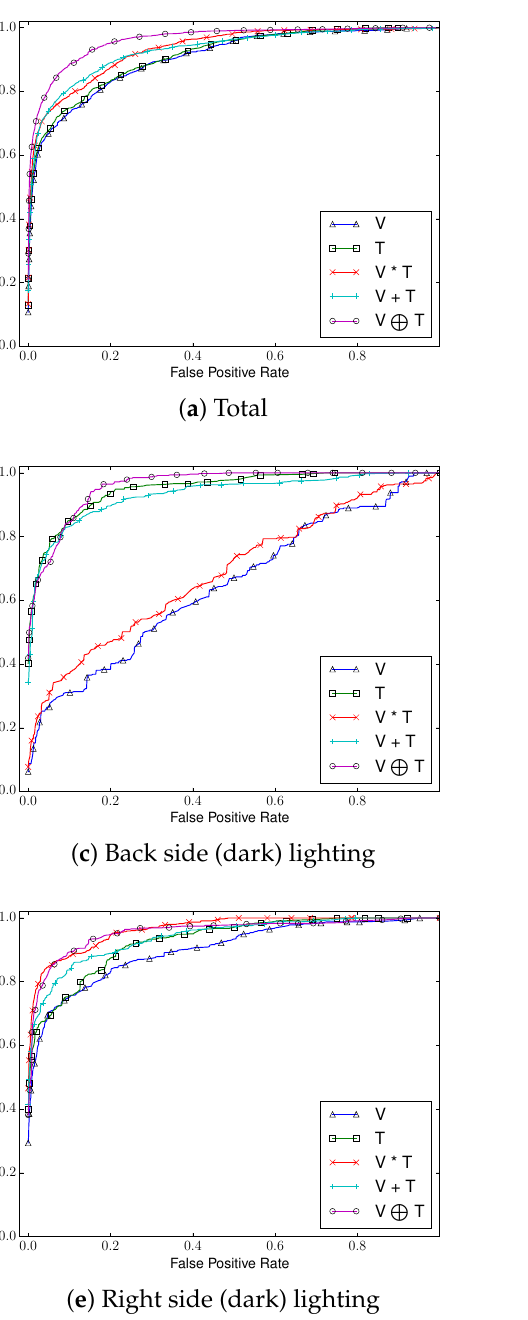
Figure 11. Receiver Operating Characteristic (ROC) curves of five compared methods in each lighting condition using CNN